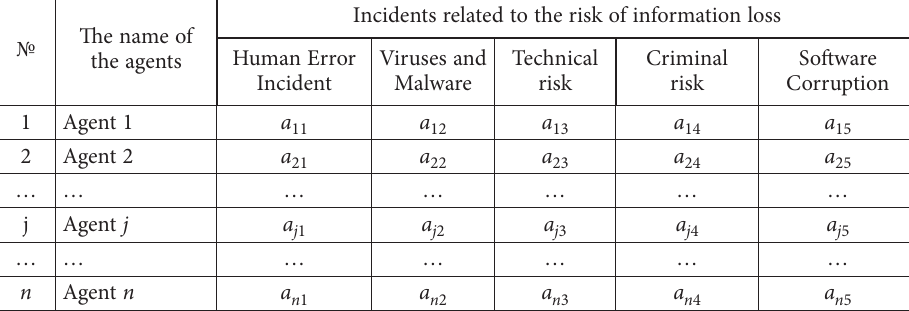
Table 1. The cases of factors that form the five incidents (source: compiled by author) The name of № the